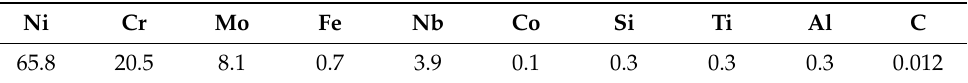
Table 1. Chemical composition (in wt.%) evaluated by EDS analysis and combustion analysis (for carbon).